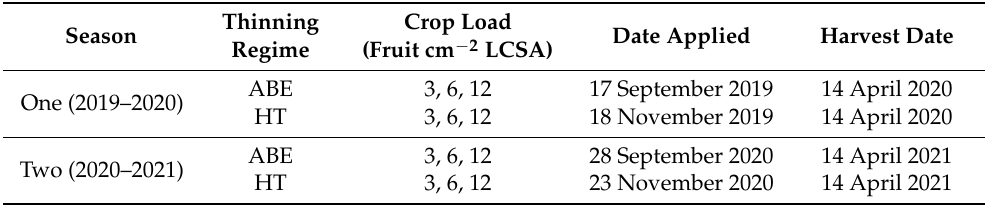
Table 1. Treatment details and dates of application and harvest. LCSA = limb cross-sectional area; ABE = artificial bud extinction; HT = hand